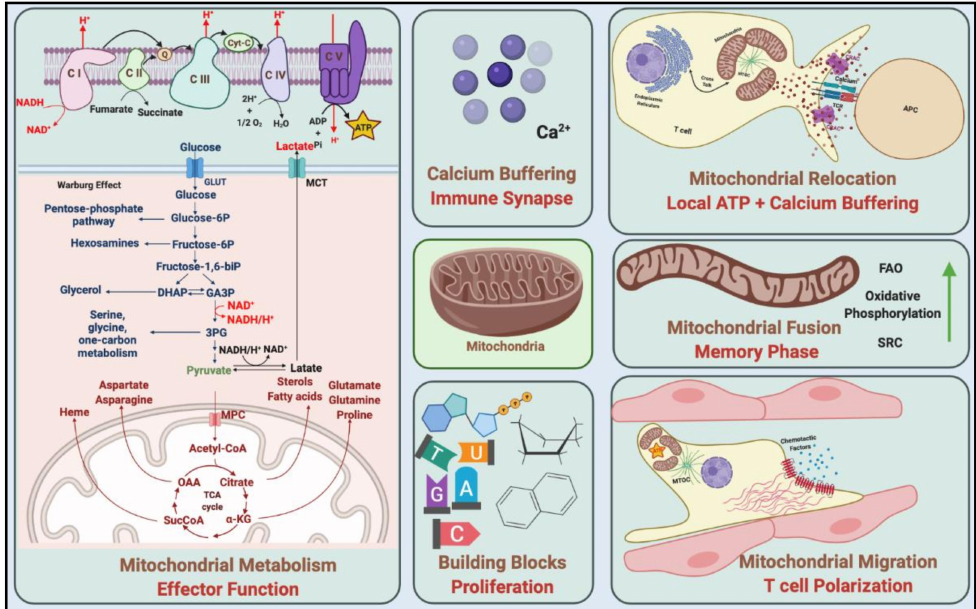
Figure 2. Mitochondrial functions in T cells. When T cells detect the chemotactic factors, mitochondria accumulate at the uropod to support the energy demand during T cell migration. Mitochondria take up calcium during stimulation and have a role in calcium homeostasis. Besides, mitochondria by anabolic metabolism provide ATP and energy for T cells, while by catabolic metabolism providing building blocks for cell proliferation. C I/II/III/IV/V, complex I/II/III/IV/V; MPC, mitochondrial pyruvate carrier; FAO, fatty acid oxidation; SRC, spare respiratory